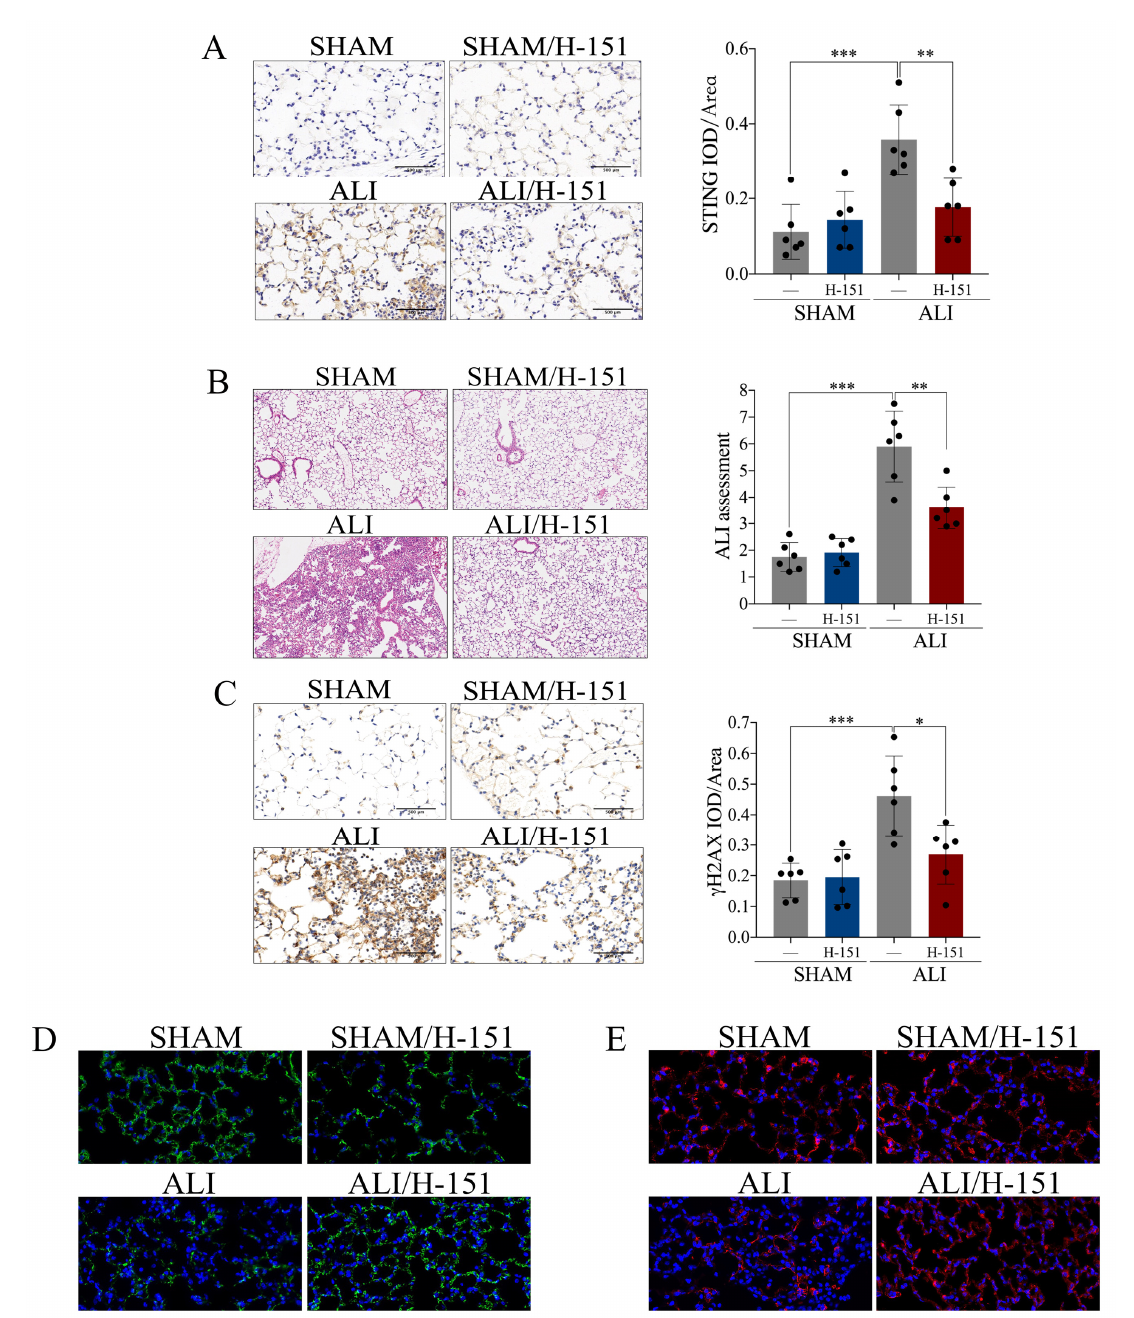
Figure 5. Pharmacological blockade of cGAS-STING confers protection against LPS-induced acute lung injury. STING inhibitor H-151 (30 mg/kg) was intraperitoneally injected 30 min before LPS administration. ( A ) Representative images of immunohistochemical staining of STING in lung tissue (scale bar = 500 µm), and statistics of the positive signal of STING in lung tissue. ( B ) Representative images of H&E staining of lung tissue (X100), and ALI assessment score. ( C ) Representative images of immunohistochemical staining of γH2AX in lung tissue (scale bar = 500 µm), and statistics of the positive signal of γ H2AX in lung tissue. ( D ) Representative images of immunofluorescence staining of ZO-1 (green) in lung tissue (X400). ( E ) Representative images of immunofluorescence staining of E-cadherin (red) in lung tissue (X400). IOD = integral optical density. Data are presented as the mean ± SD, n = 6 per group, * p < 0.05, ** p < 0.01, *** p < 0.001. Comparisons between two groups were analyzed by an unpaired t test; otherwise, one-way analysis of variance was performed, and Tukey’s test was used to perform pairwise